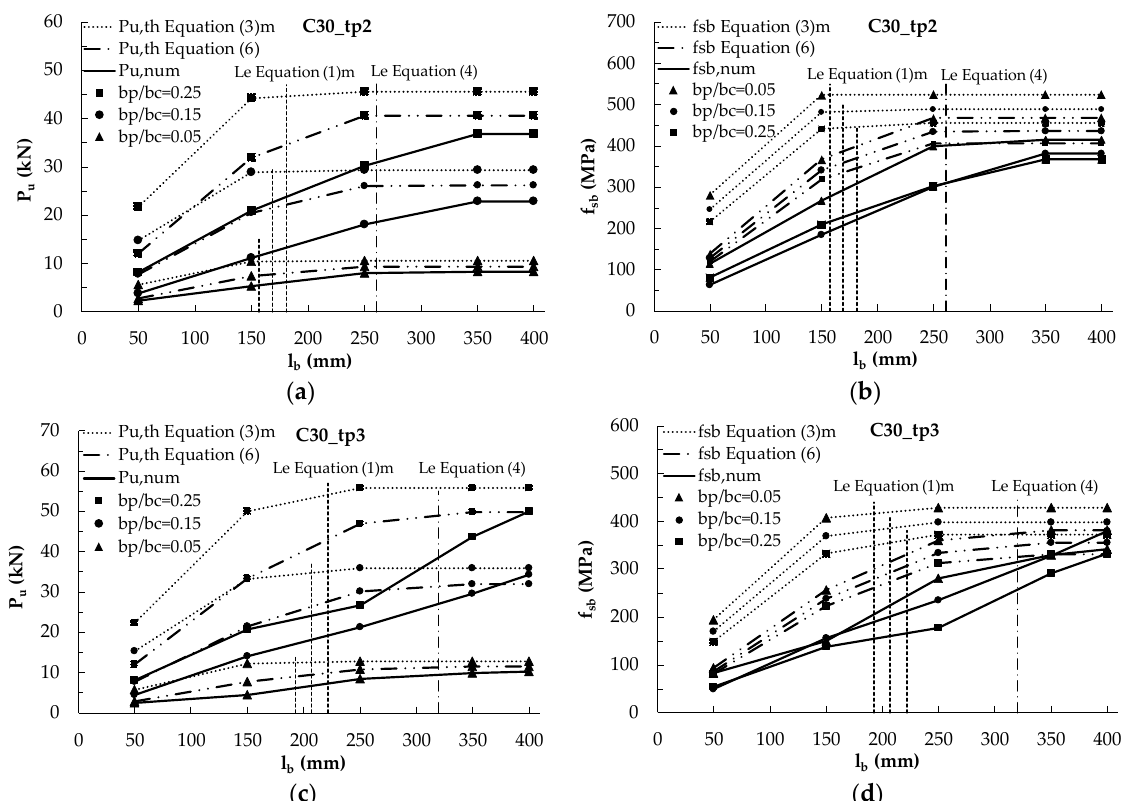
Figure 8. Numerical and mean theoretical debonding load and corresponding tensile stress f sb (Equations (3) and (6)) vs. bonded length for a concrete C30 and different values of b p /b c for: ( a ) and ( b ) t p = 2 mm; ( c ), ( d ) t p = 3 mm.